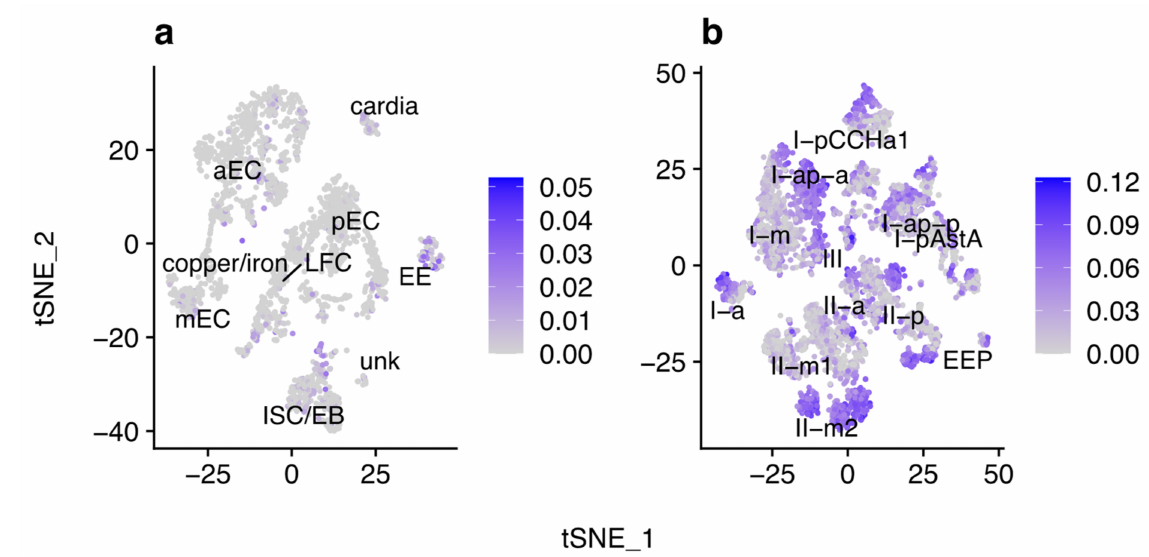
Figure 5. Hsf regulon activity in cells from the entire fly’s midgut ( a ) and EEs ( b ) showing AUC values for each cell. Each point represents a single